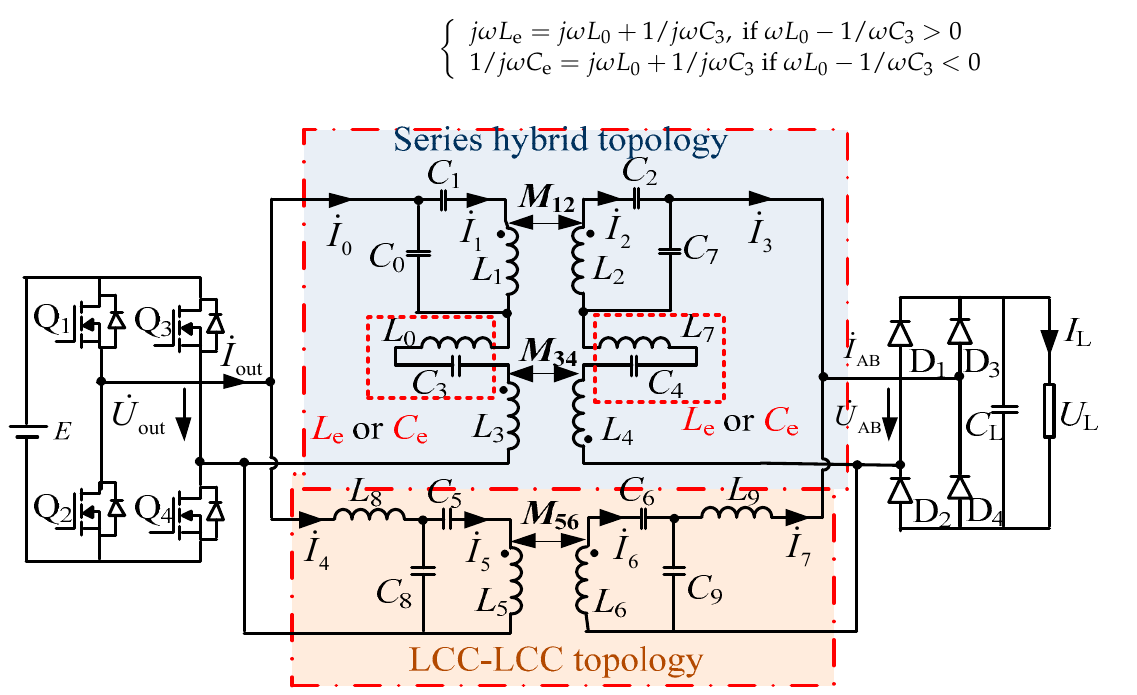
Figure 2. Proposed hybrid IPT system.